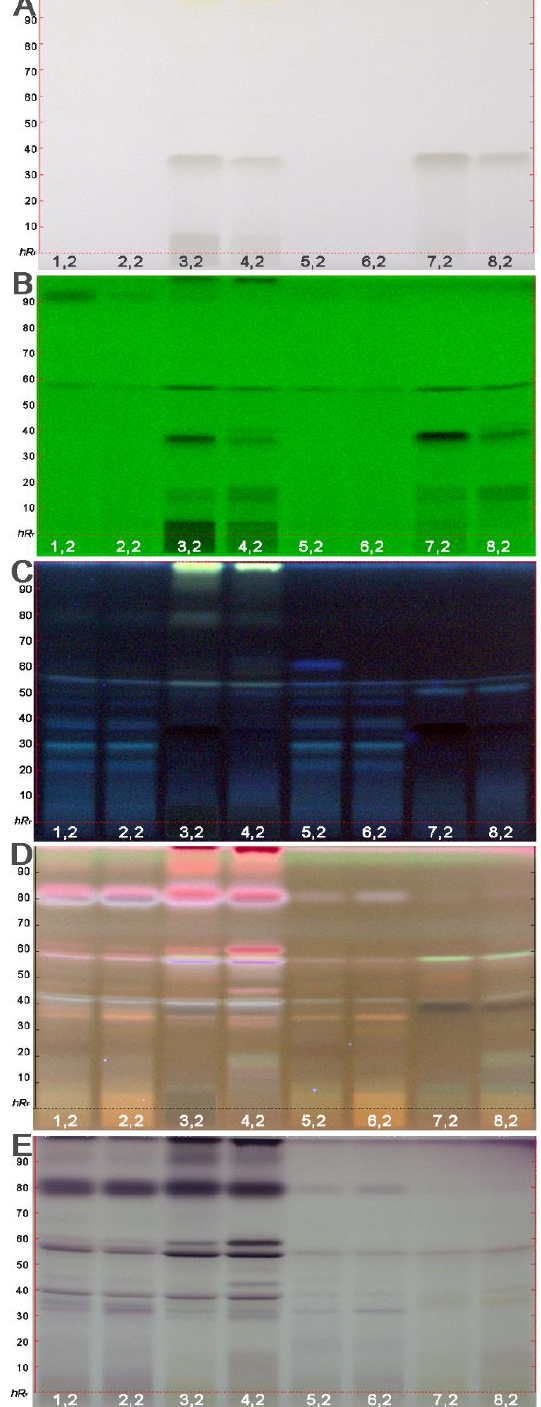
Figure 3. Physico-chemical profiling: HPTLC chromatograms at white light illumination (Vis, A ), UV 254 nm ( B ), FLD 366 nm ( C ) and after derivatization with anisaldehyde sulfuric acid reagent ( D FLD 366 nm and E Vis) of the puree and juice extracts (IDs 1–8, Table 2, 0.2 g/mL in ethyl acetate, 100 µL/area of 8.0 × 6.0 mm) developed on HPTLC plates silica gel 60 F 254 with toluene – ethyl acetate – methanol – formic acid 2.4:1.8:0.7:0.06, V/V/V/V, in twin-trough chamber 10 cm × 10 cm. In the FLD 366 nm chromatogram (Figure 3C), a dominantly yellow fluorescent zone was observed in the solvent front of the mango puree extracts (IDs 3,2 and 4,2). This zone was also visible and UV-active as mentioned. Tentatively, more blue fluorescent zones were observed in the pineapple (IDs 1,2; 2,2; 5,2 and 6,2) than mango products (IDs 3,2;